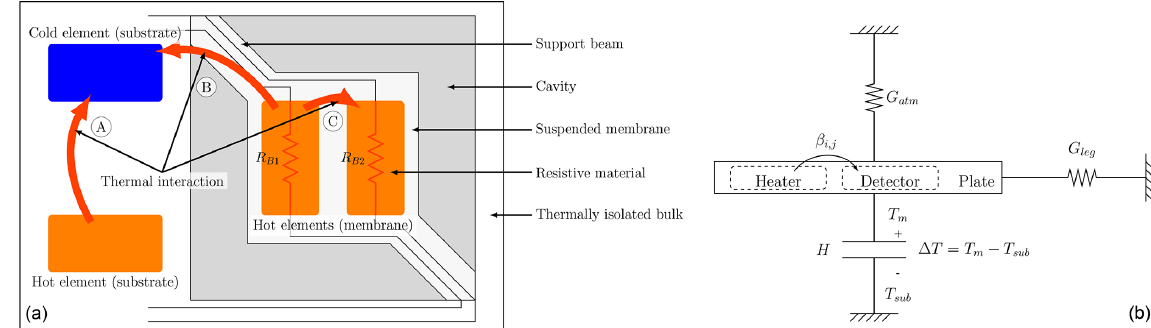
Figure 1. The operating principles and the thermal model for a generic dual-resistive element device. (a) The device topology highlighting the required components of the device structure and the thermal linkage that exists between the resistive elements. (b) An equivalent heat flow diagram for a generic two-element device. The elements are labelled as the heater and detector, although each element can serve as